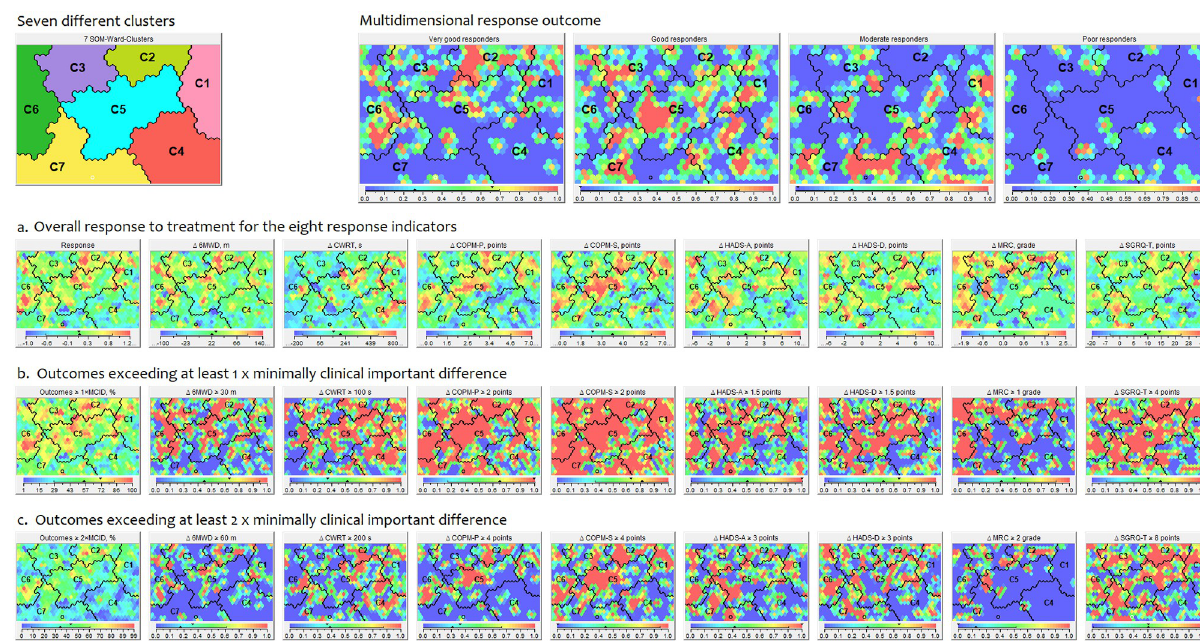
Fig 3. Outcomes after pulmonary rehabilitation for the seven traits-based clusters. Panels generated using Viscovery (Viscovery Software GmbH, Vienna, Austria). The seven different traits-based clusters are demonstrated in the upper left corner. The four panels next to it, illustrate (in red) the proportion of very good responders, good responders, moderate responders and poor responders for the different